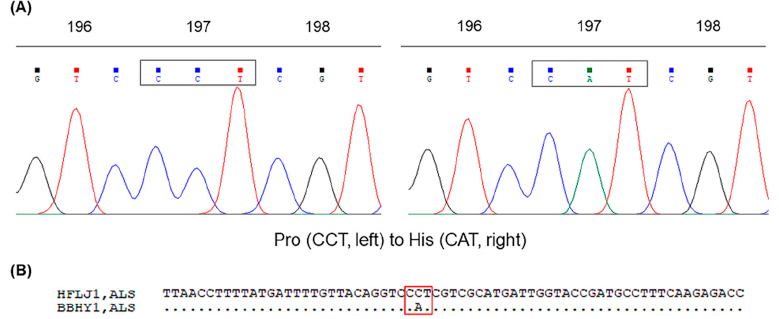
Figure 3. Gene sequencing of ALS from BBHY1 and HFLJ1 populations. ( A ) A P197H substitution of ALS in the R plants (BBHY1, right) compared with the S plants (HFLJ1, left). ( B ) Partial fragments of ALS genes used to sequence were derived from the S (HFLJ1) and R (BBHY1) plants. The region with a square represents the mutation at codon position 197 of ALS .